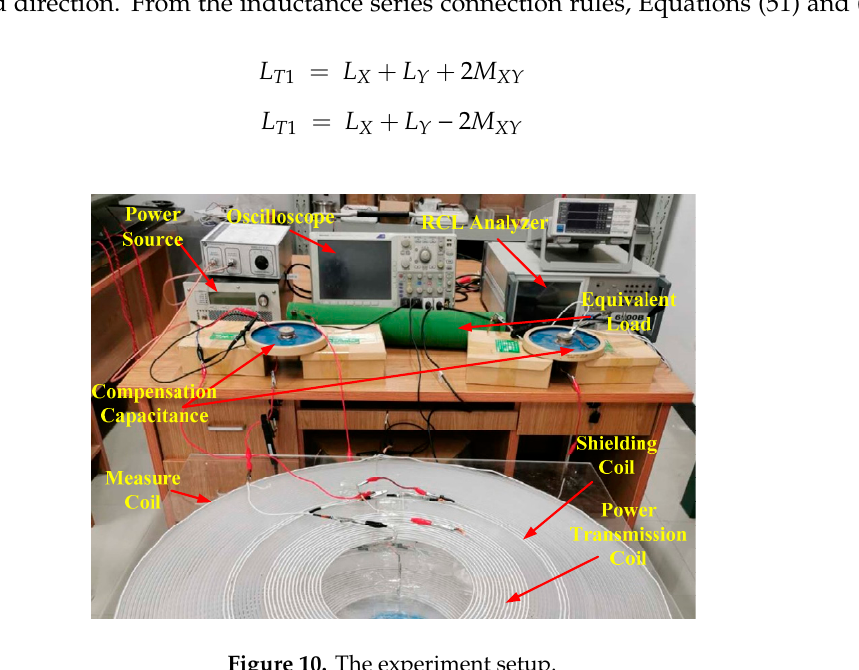
Figure 10. The experiment setup.